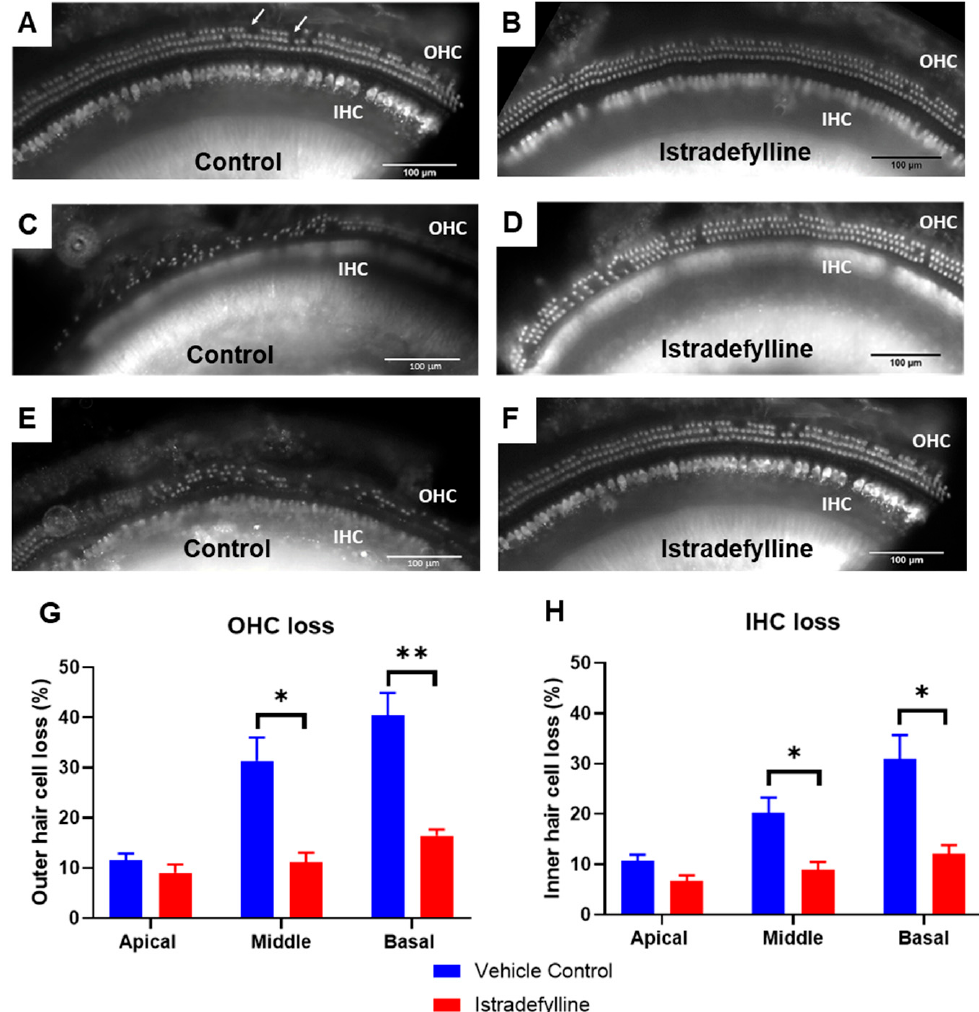
Figure 3. Representative images of the organ of Corti in the apical turn of the cochlea in ( A ) control vehicle-treated and ( B ) istradefylline-treated mice. Anti-Myosin VIIa antibody was used to label sensory hair cells. White arrows point at missing hair cells. Representative images of the organ of Corti are also shown in the middle ( C , D ) and basal ( E , F ) turns of the cochlea. ( G ) OHC loss (%) in the apical, middle, and basal cochlear turns in vehicle- and istradefylline-treated mice. ( H ) IHC loss (%). Data presented as mean ± SEM. Vehicle control, n = 13; istradefylline, n = 12. * p < 0.05, ** p < 0.01. Two-way ANOVA followed by Holm–Sidak post hoc